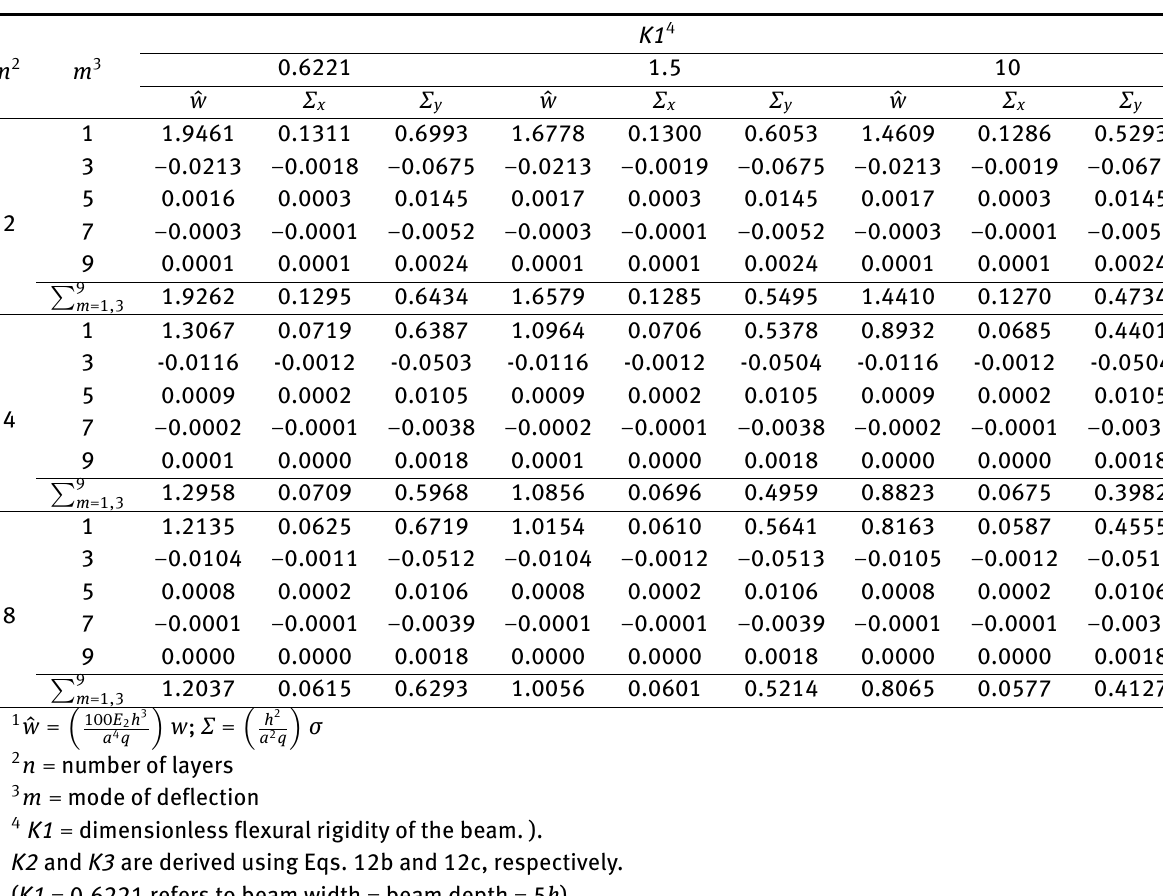
Table 6: Influence of the number of layers on the ASM convergence of the center deflection ( ^ w 1 ) and stresses ( Σ 1 x and Σ 1 y ) of antisymmetric cross-ply square plates having three edges simply supported and the fourth edge ( x = a ) beam supported ( a / h = 1000, E 1 = 132.38